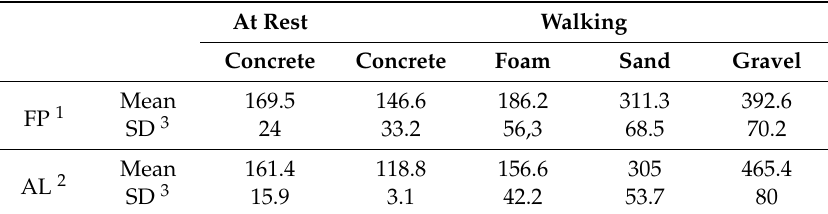
Table 3. Means and standard deviations of reaction times, showing results when reaction time is obtained at rest position and when participants were walking.